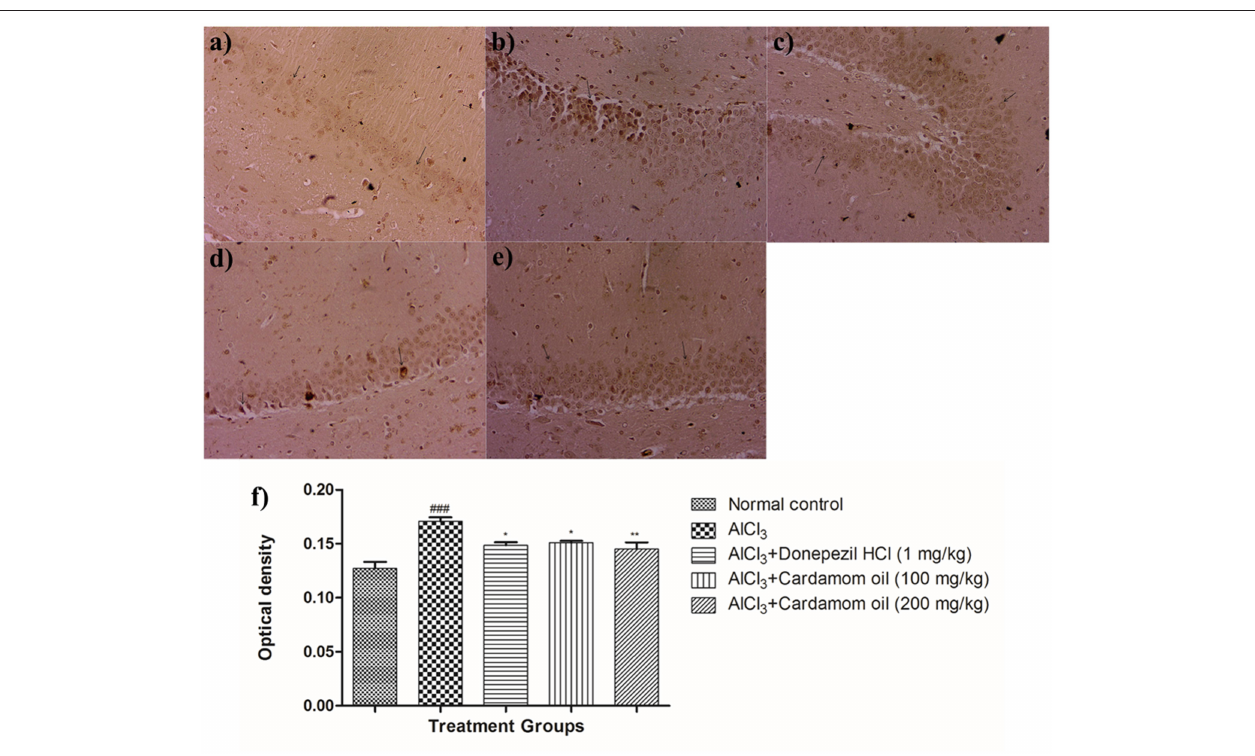
FIGURE 9 | Effect of Cardamom oil on amyloid β expression in hippocampus tissue (400X). (a) Normal control: Hippocampus: showing normal neuronal cells without immunoreactivity (arrow){Immunostaining: Amyloid- β , 400X}, (b) AlCl 3 group: Hippocampus: showing significantly mild enhanced expression of amyloid- β , exhibited by brown coloration (arrow){Immunostaining: Amyloid- β , 400X}, (c) AlCl 3 + Donepezil hydrochloride (1 mg/kg): Hippocampus: showing normal histology, normal neuronal cells without immunoreactivity (arrow) {Immunostaining: Amyloid- β , 400X}, (d) AlCl 3 + Cardamom oil (100 mg/kg): Hippocampus: showing significantly enhanced expression of amyloid- β , exhibited by brown coloration (arrow) {Immunostaining: Amyloid- β , 400X}, (e) AlCl 3 + Cardamom oil (200 mg/kg): Hippocampus: showing normal histology, normal neuronal cells without immunoreactivity (arrow){Immunostaining: Amyloid- β , 400X}, (f) Histogram of IHC. Data are expressed as mean ± SEM ( n = 6), ### p < 0.001 when compared with normal control, ** p < 0.01, * p < 0.05 when compared with disease control group. The magnification was 400X. AlCl 3 , Aluminum chloride; SEM, Standard Error of Mean; IHC,